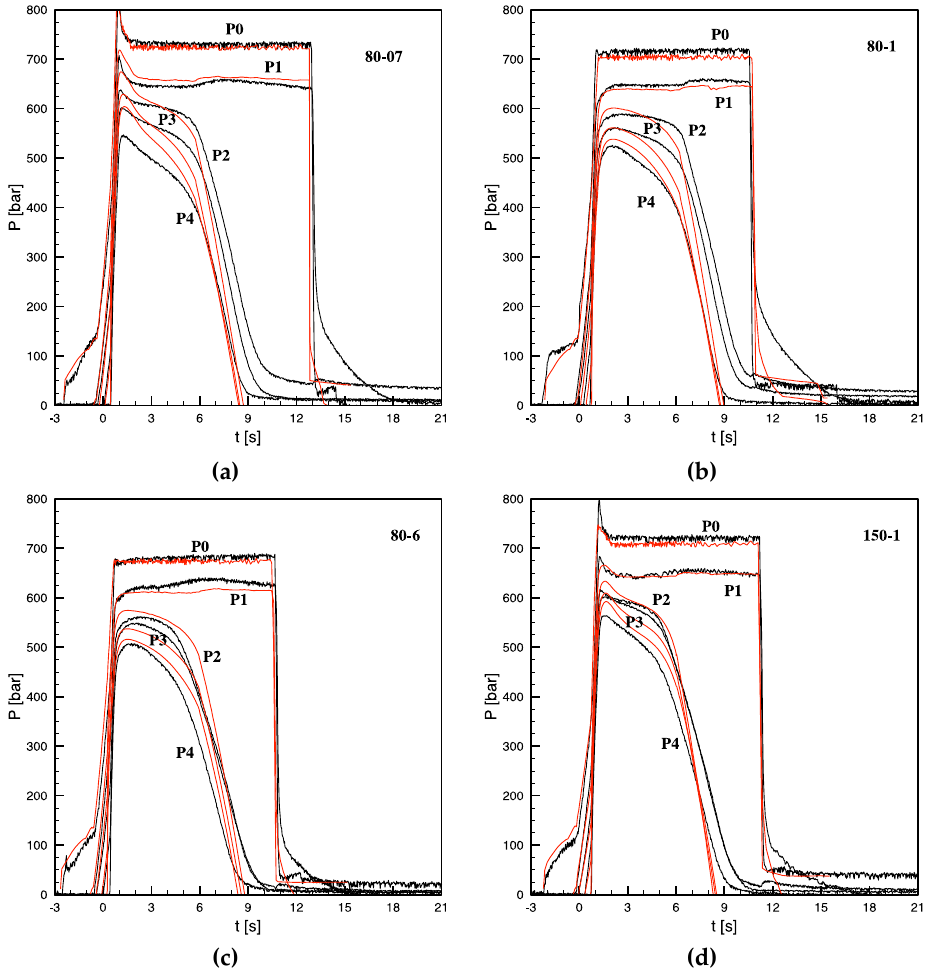
Figure 2. Comparison between experimental (black lines) and simulated (red lines) pressure evolutions for the tests carried out with heating powers 4 W/cm 2 and 9.5 W/cm 2 with different heating time as specified in single plot. ( a ) 80 °C and 0.7 s, ( b ) 80 °C and 1.3 s, ( c ) 80 °C and 6 s, ( d ) 150 °C and 1.3 s.